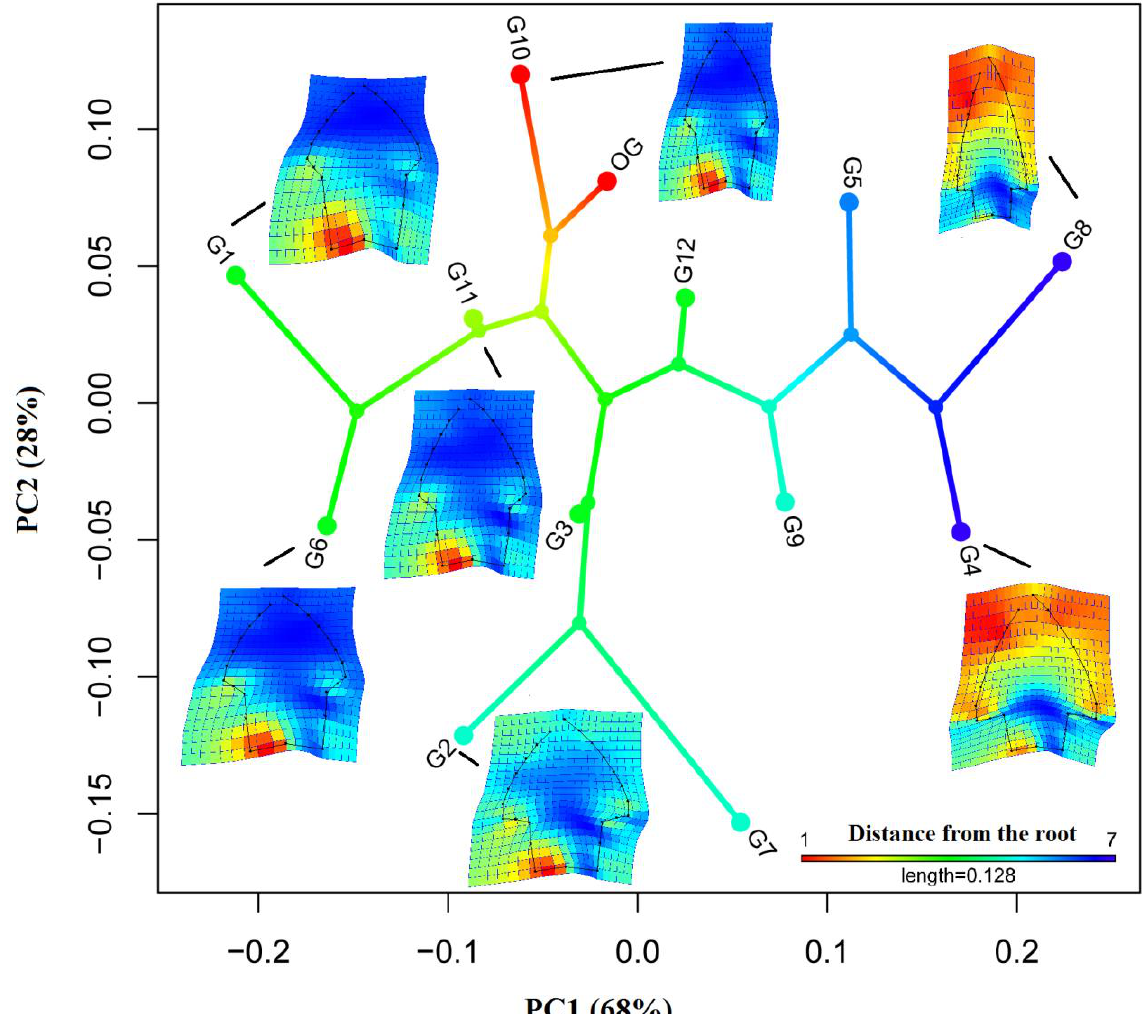
Figure 7. Phylomorphospace plot showing the diversification pattern on shape space using the resolved tree (Figure 4A). Branch colour shows distance to the root. Thin plate spline reconstructed shapes represent deformation between out-group and